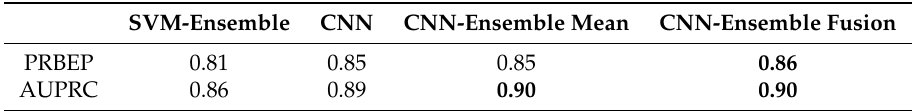
Figure 5. PR-curves of SVM-ensemble and deep learning solutions. All the classifiers disposed of the same amount of (limited) data for the training. Table 3. Precision-Recall Break Even Point and Area Under Precision-Recall Curve with the different architectures trained on the same limited amount of